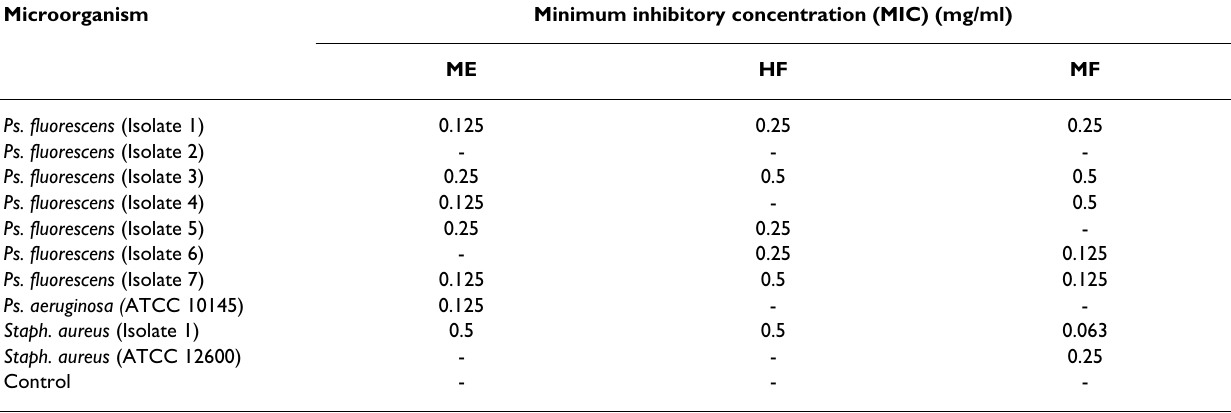
Table 4: Minimum inhibitory concentration of extract and fractions